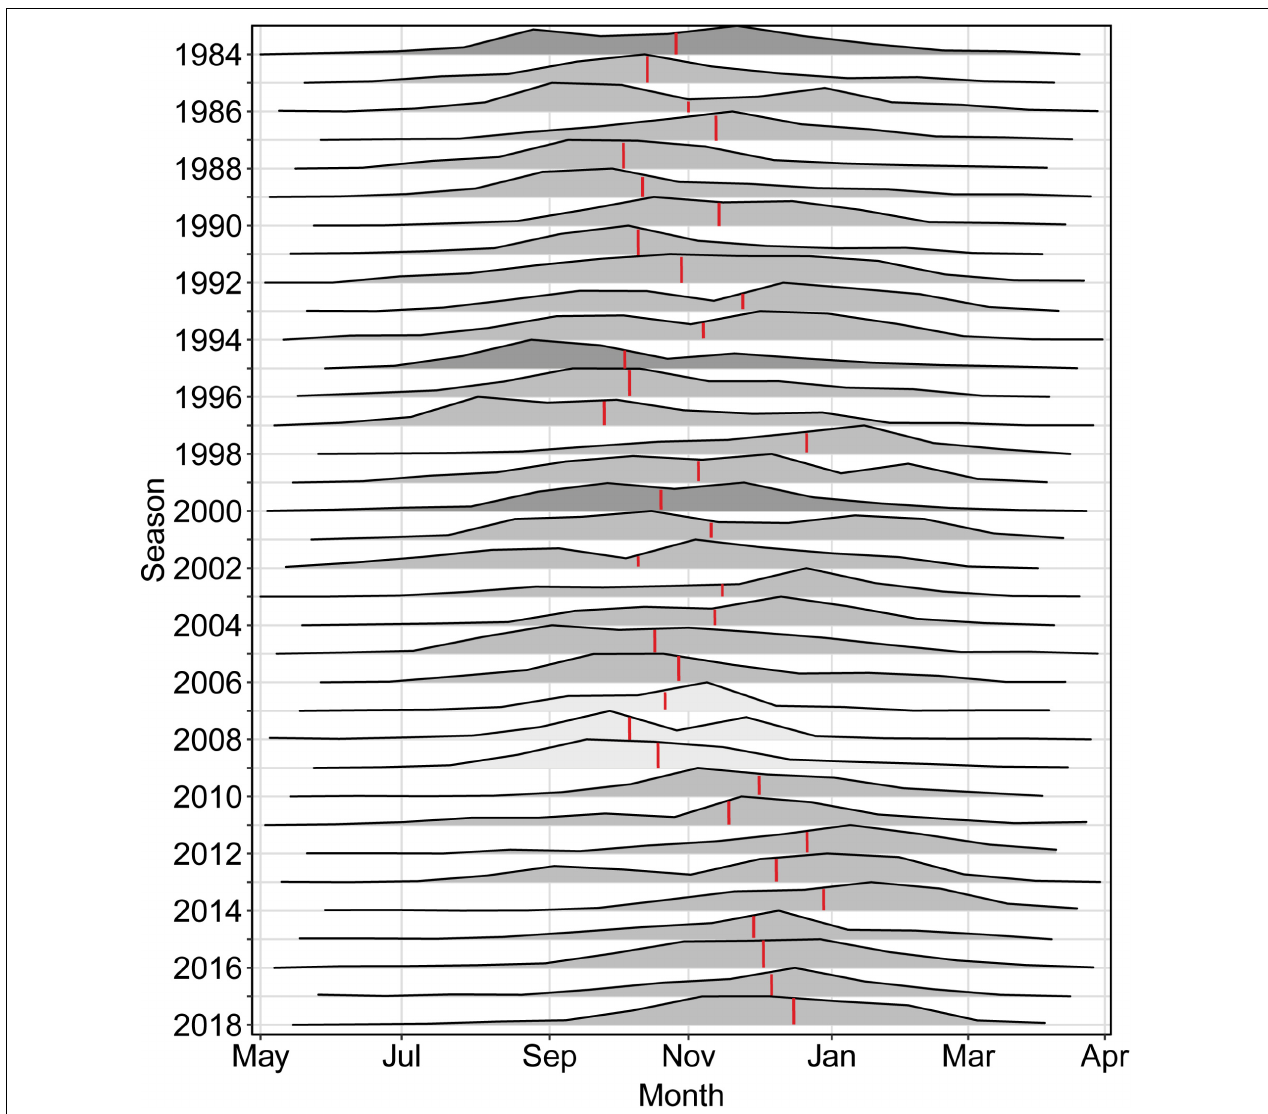
FIGURE 4 | Adjusted settlement ridgeline plot over all puerulus sites from 1990 to 2018, displaying the timing of puerulus settling into the fishery throughout the season. Red line indicates the mean timing for the whole season starting May 1. Light gray seasons are those with a PI in the lowest 10 percentile, dark gray seasons had a PI in the highest 90